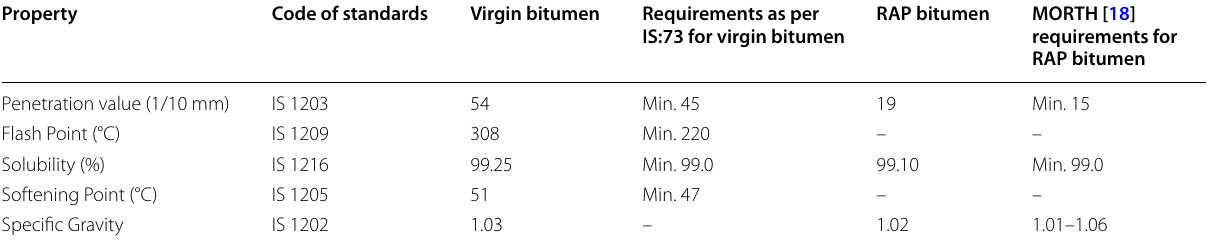
Table 2 Properties of virgin and RAP